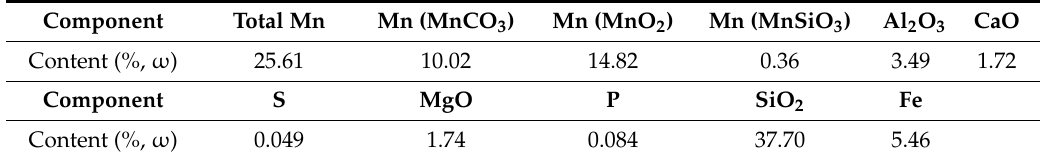
Table 1. Bulk chemical composition of semi-oxidized manganese ore sample (mass fraction, %).